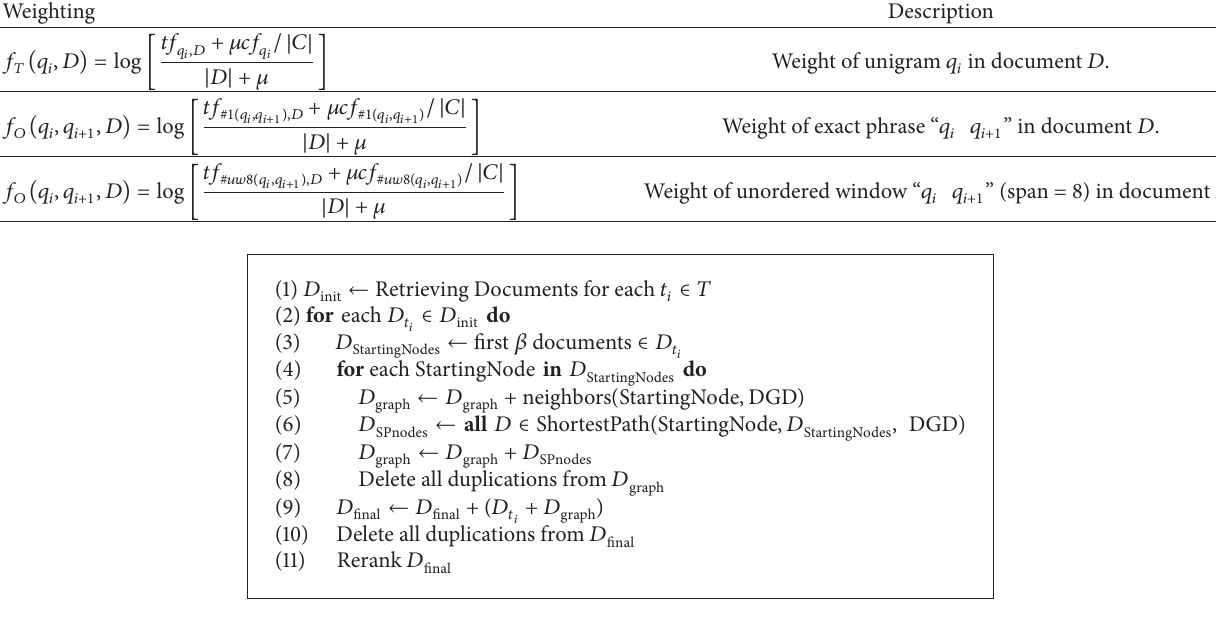
Algorithm 1: Retrieving based on DGD feedback.